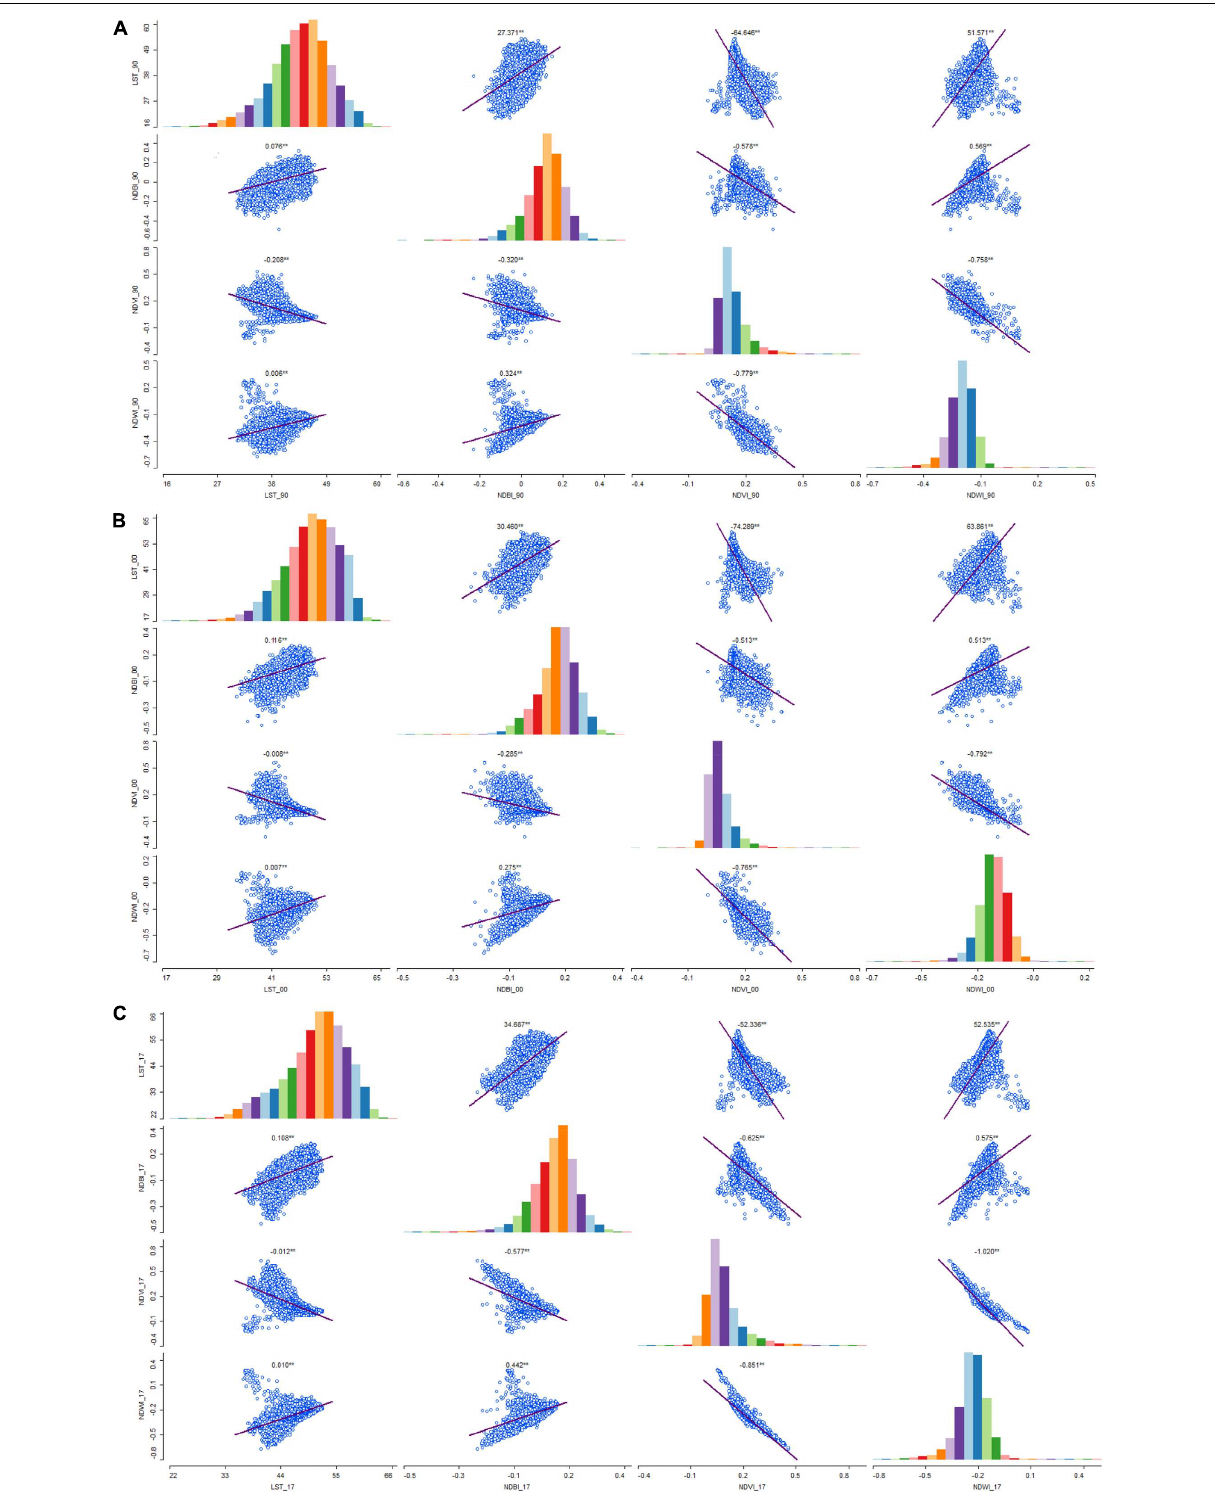
Frontiers in Ecology and Evolution |